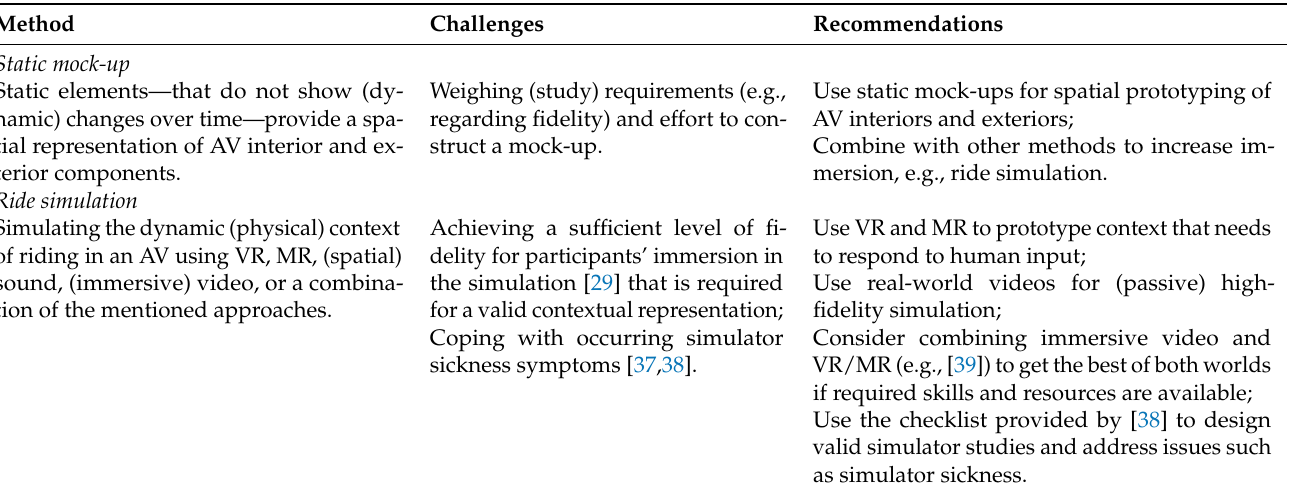
Table 1. Overview of the discussed methods and their challenges, along with our recommendations for context-based prototyping of human–AV